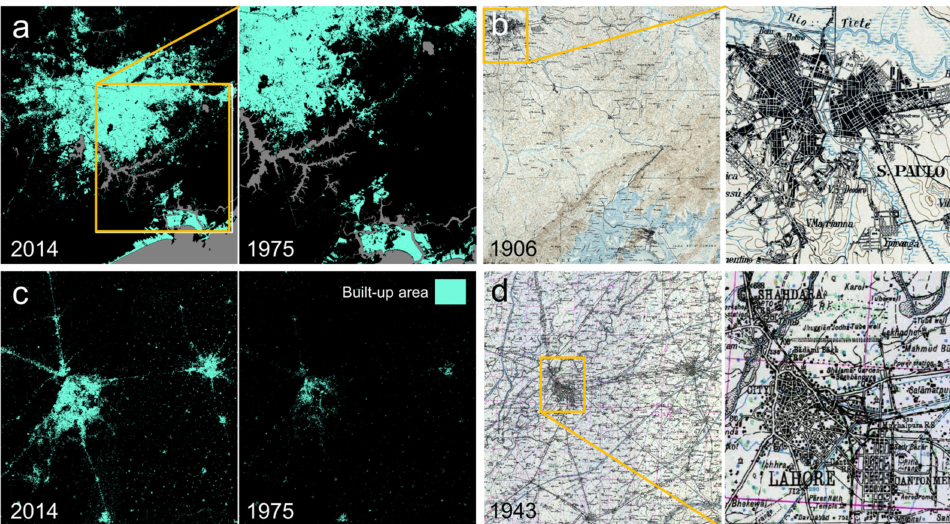
Figure 2. Input data for the study areas in South America and Asia: ( a ) GHSL built-up areas in 2014 and 1975 for the greater Sao Paulo area (Brazil), including the coastal city of Santos, ( b ) historical topographic map from 1906 (scale: 1:100,000) covering the same area, ( c ) GHSL built-up areas in 2014 and 1975 for the Lahore (Pakistan) and Amritsar (India) region, and ( d ) historical topographic map from 1943 (approximate scale: